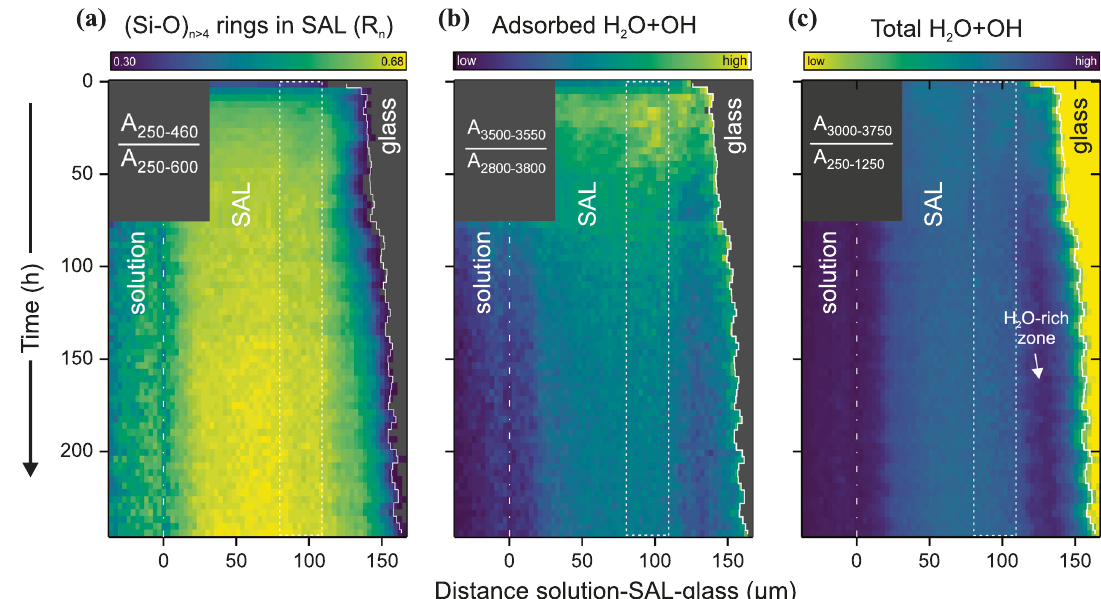
Fig. 3 Spatial and temporal evolution of the surface alteration layer. False-colour Raman images rendered from the recorded spectra over time, showing the spatial distribution of ( a ) the relative fraction of fi ve- and sixfold rings in silica, b the relative fraction of adsorbed water on the silica surface, and c OH groups in the analysed volume. The images were obtained by colour-coding the ratios A 250 – 460 / A 250 – 600 , A 3500 – 3550 / A 2800 – 3800 , and A 3000 – 3750 / A 250 – 1250 , where A represents the accumulated and background-corrected intensity in the frequency range given as index (in cm − 1 ). Dashed lines encase pro fi le location shown in Fig. 4, white lines represent the location of the retreating silica/glass interface, which is derived from sigmoidal fi ts of the intensity of the OH bands. Grey areas in the top-left were initially not imaged. Glass areas in ( a and b ) are also shown in grey as the selected regions of integrated Raman band intensities are not directly applicable for